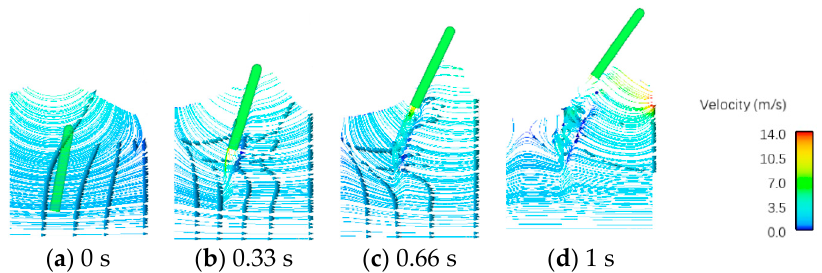
Figure 12. Streamline diagram of vehicle fl ying out of water in case 2.